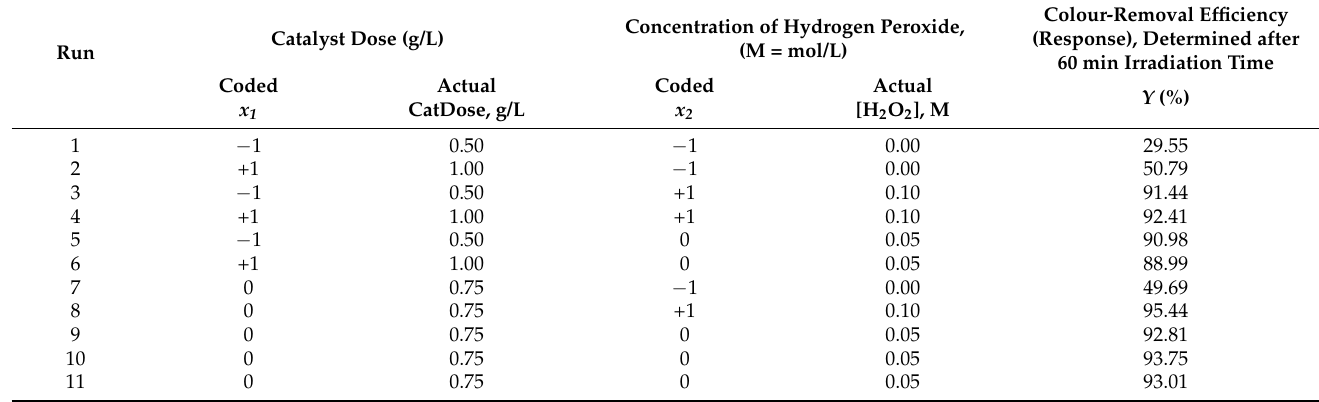
Table 3. Central composite design of face-centred type employed for